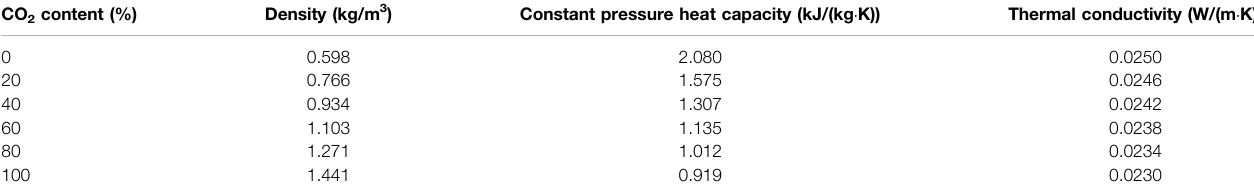
TABLE 2 | Numerical parameters with different CO 2 contents in the gas-steam mixture (100 ° C, 1 atm). CO 2 content (%) Density (kg/m 3 ) Constant pressure heat capacity (kJ/(kg · K)) Thermal conductivity (W/(m · K))